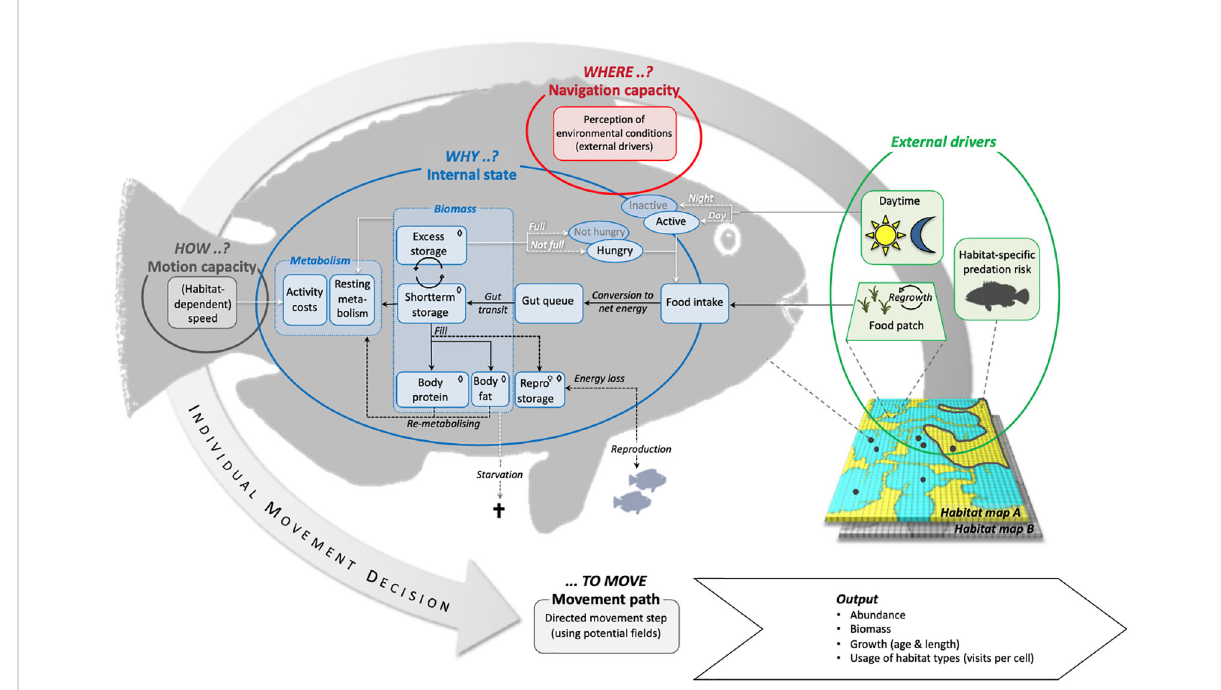
FIGURE 1 Overview of basic model processes and linkages between model compartments according to the listed components where, how, why … to move in Nathan et al. (2008). → fl ow of energy, ⇨ fl ow of information, ⇢ conditional fl uxes of energy or information, ◊ compartment size depending on individual body length, ♀ applies solely to female